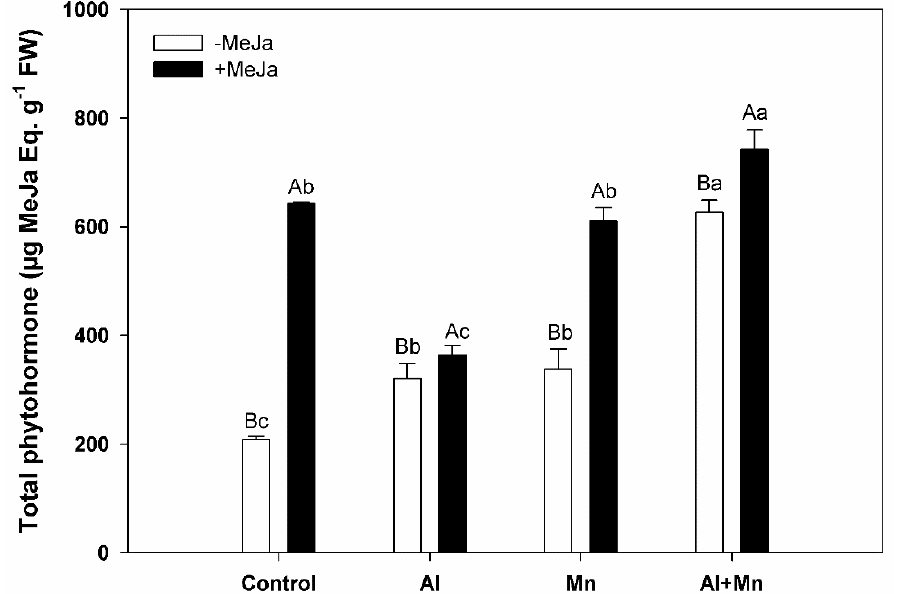
Figure 3. Total phytohormone in leaves of highbush blueberry cv. Legacy plants subjected to different soil treatments (Al, Mn, and Al–Mn toxicity), and exogenous MeJA. All values represent averages of 10 biological replicates ± SE. Different upper-case letters indicate significant differences between MeJA treatments for the same soil conditions according to Tukey’s test ( p ≤ 0.01). Different lower-case letters indicate significant differences among soil conditions for the same MeJA treatment according to Tukey’s test ( p ≤ 0.01).